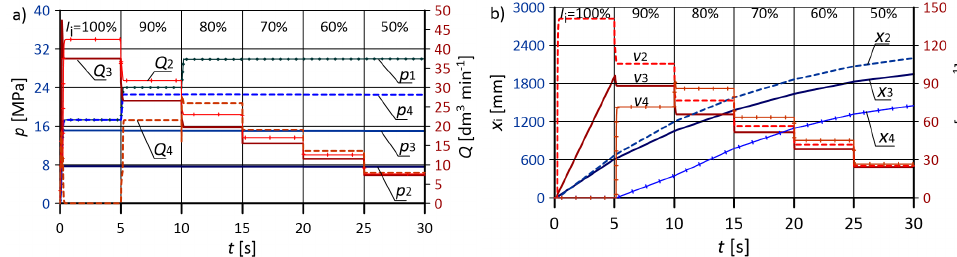
Figure 10. Results of the base system with variable load: F load ,2 = 37.5 kN, F load ,3 = 75 kN, F load ,4 = 112.5 kN; ( a ) pressures and flow rates, ( b ) speeds and positions of